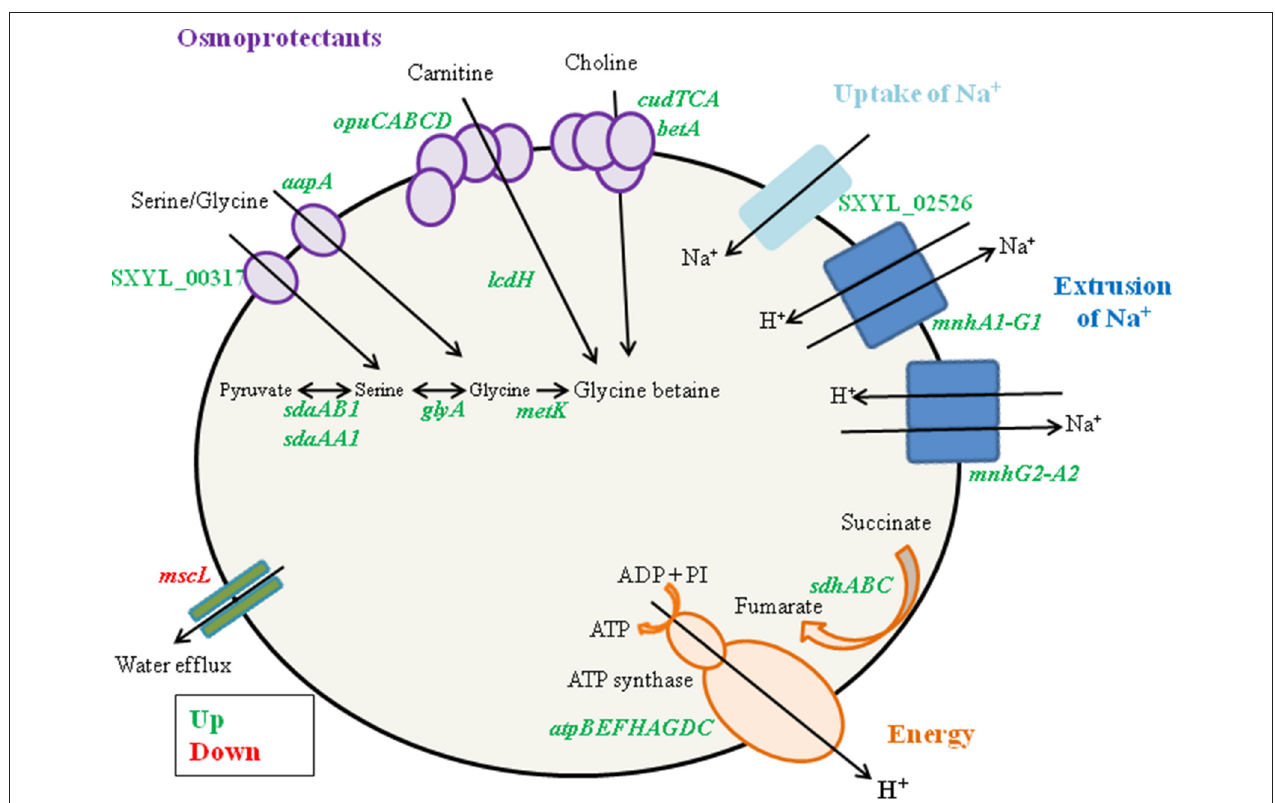
FIGURE 2 | Summary of the Staphylococcus xylosus response to osmotic stress generated by NaCl in a meat